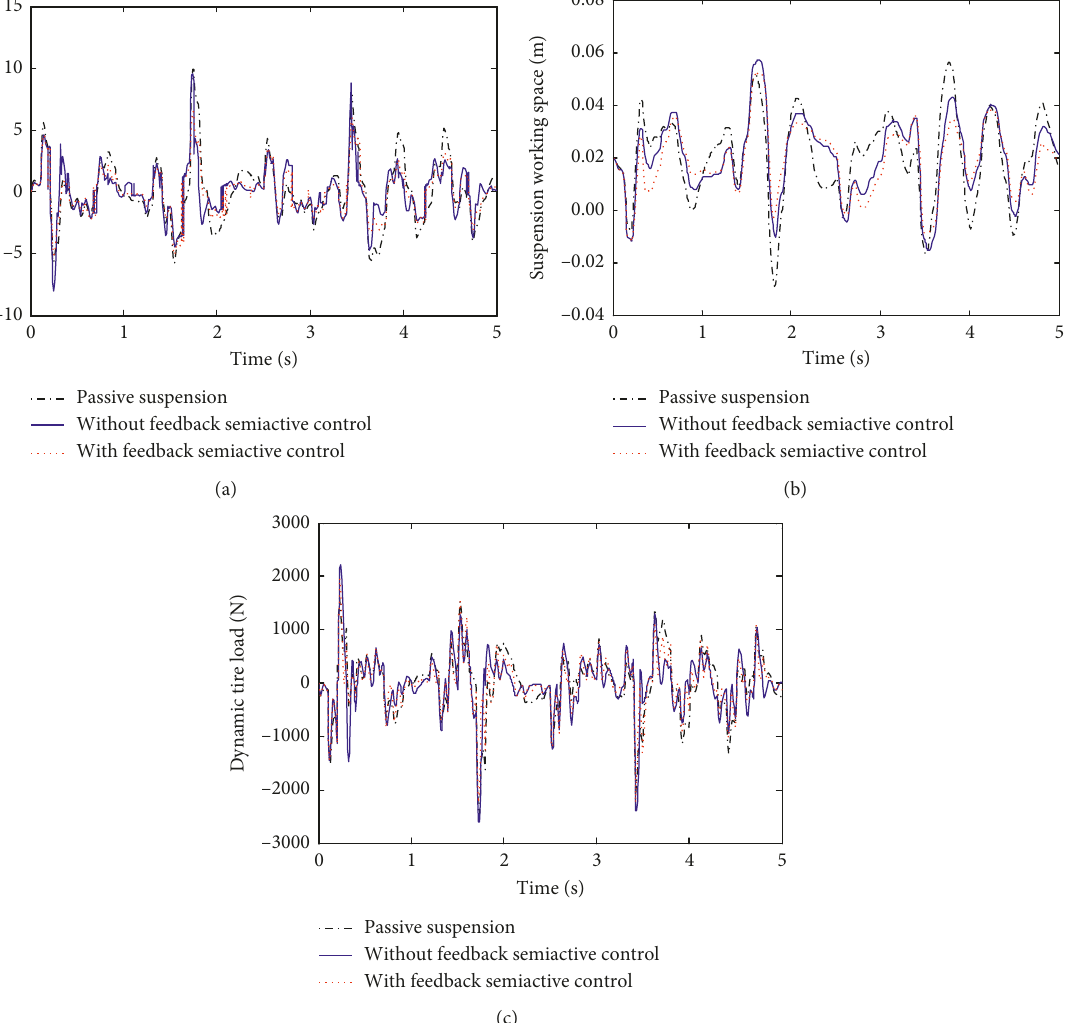
Figure 16: The dynamic responses of the hybrid suspension in semiactive control. (a) The response curves of sprung mass acceleration. (b) The response curves of suspension working space. (c) The response curves of dynamic tire load.